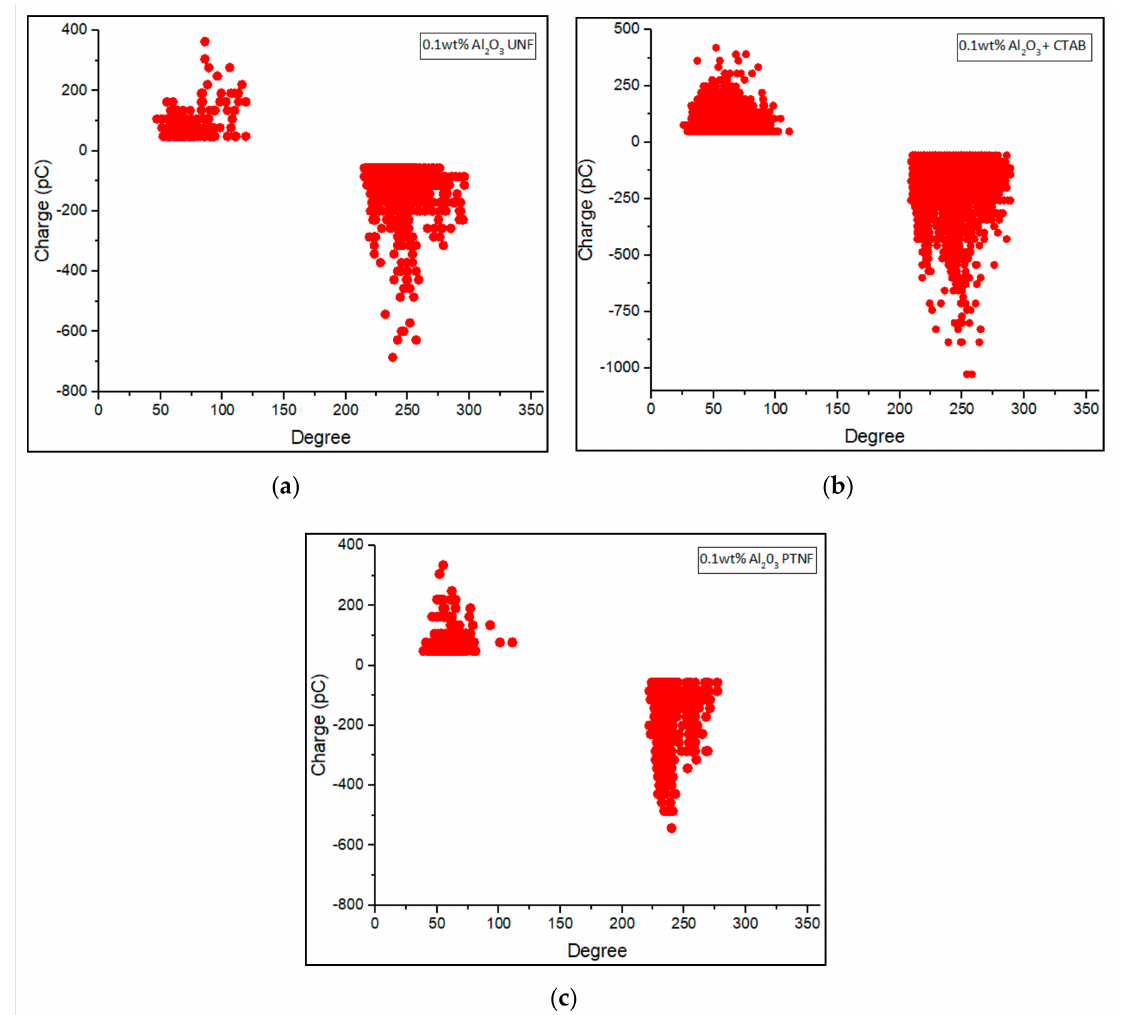
Figure 10. Phase—resolved PD patterns of ( a ) 0.1 wt% Al 2 O 3 UNF, ( b ) 0.1 wt% Al 2 O 3 + CTAB NF, and ( c ) 0.1 wt% Al 2 O 3 PTNF.